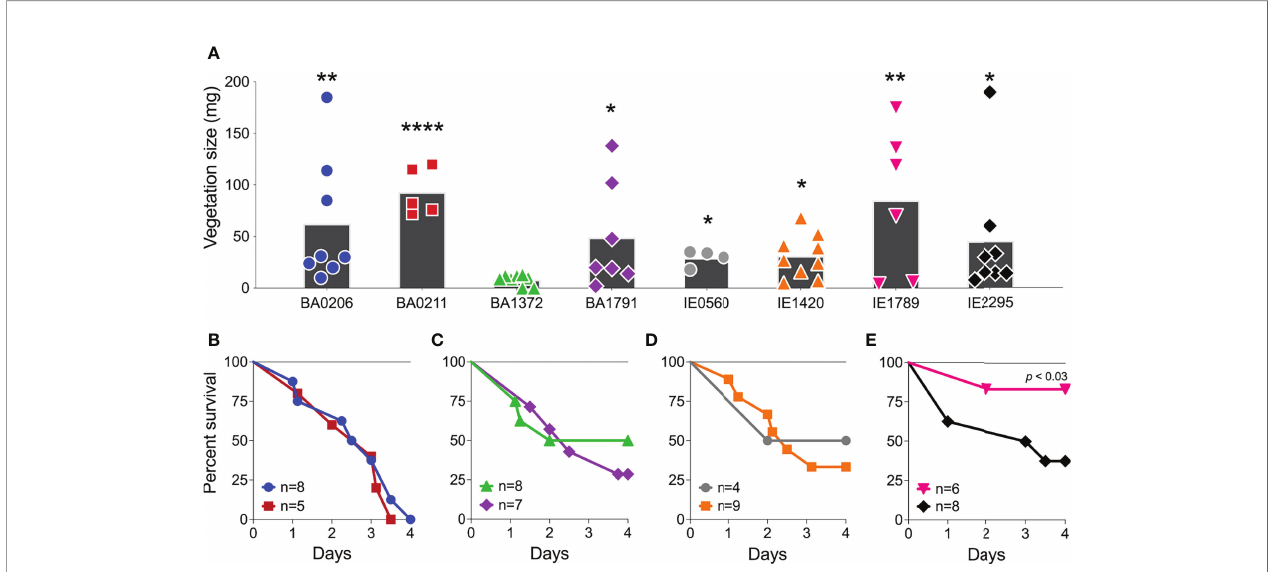
FIGURE 1 | Differential development of infective endocarditis and lethality in S. aureus CC5 strains. Rabbit model of native valve IE and sepsis. Rabbits were injected intravenously with 1.3 – 3.6 x 10 7 CFUs of S. aureus CC5 isolates after mechanical damage of aortic valve and monitored over 4 days. (A) Total weight of vegetations dissected from aortic valves. *, p < 0.05, **, p < 0.005, ****, p < 0.0001, one-way ANOVA, non-parametric Kruskal-Wallis with uncorrected Dunn ’ s multiple comparison test to BA1372 (IE-de fi cient). Bars represent mean value. (B – E) Percent survival. (B) BA0206 and BA0211. (C) BA1372 and BAA1791. (D) IE0560 and IE1420. (E) IE1789 and IE2295. p < 0.03, Log-rank (Mantel-Cox) of IE1789 compared to each